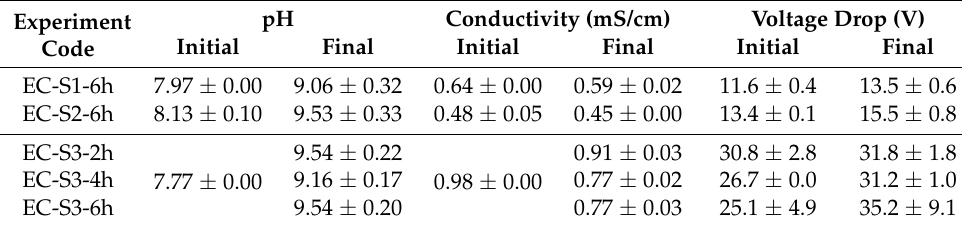
Table 2. Effluent pH, conductivity, and voltage drop (mean ± standard deviation) along the EC experiments of Set 2.